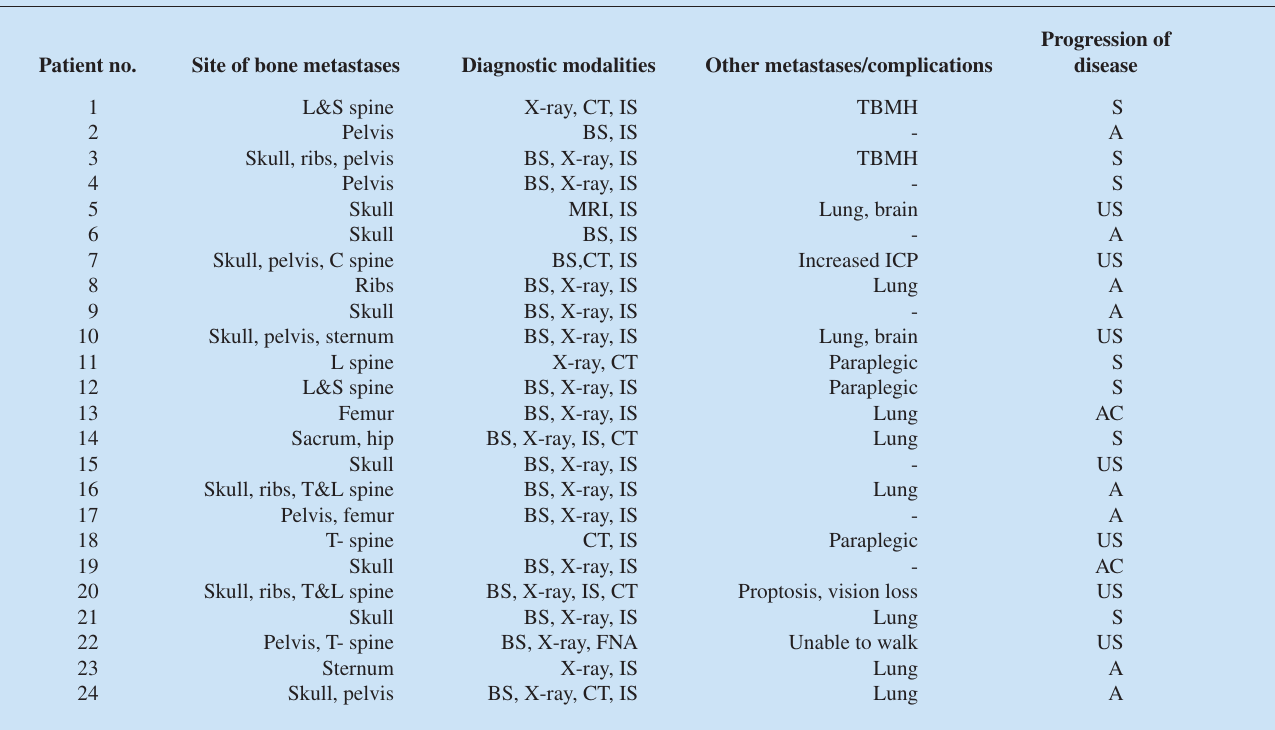
Table III. Metastatic sites, diagnostic modalities and course of disease Patient